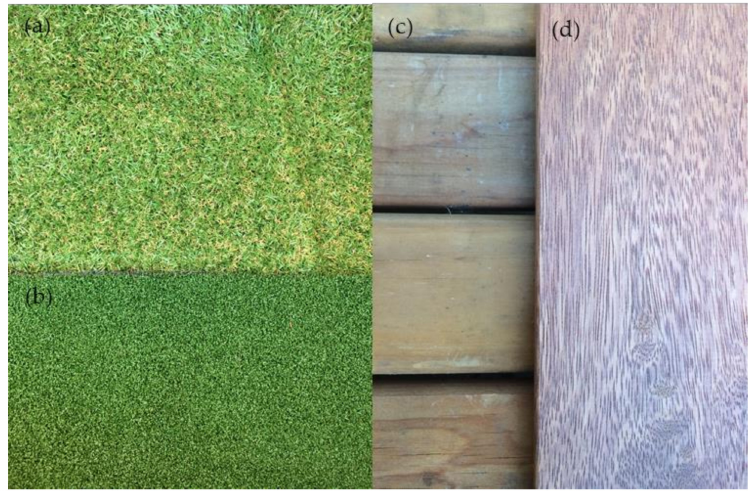
Figure 4. Di ff erent materials used in phase 1 and phase 2: ( a ) phase 1 artificial grass; ( b ) phase 2 artificial grass; ( c ) phase 1 decking; ( d ) phase 2 decking.